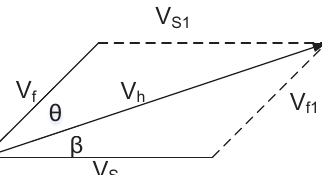
Figure 8. When consider the wind speed and wind direction, how to control the flight speed and direction of UAV.